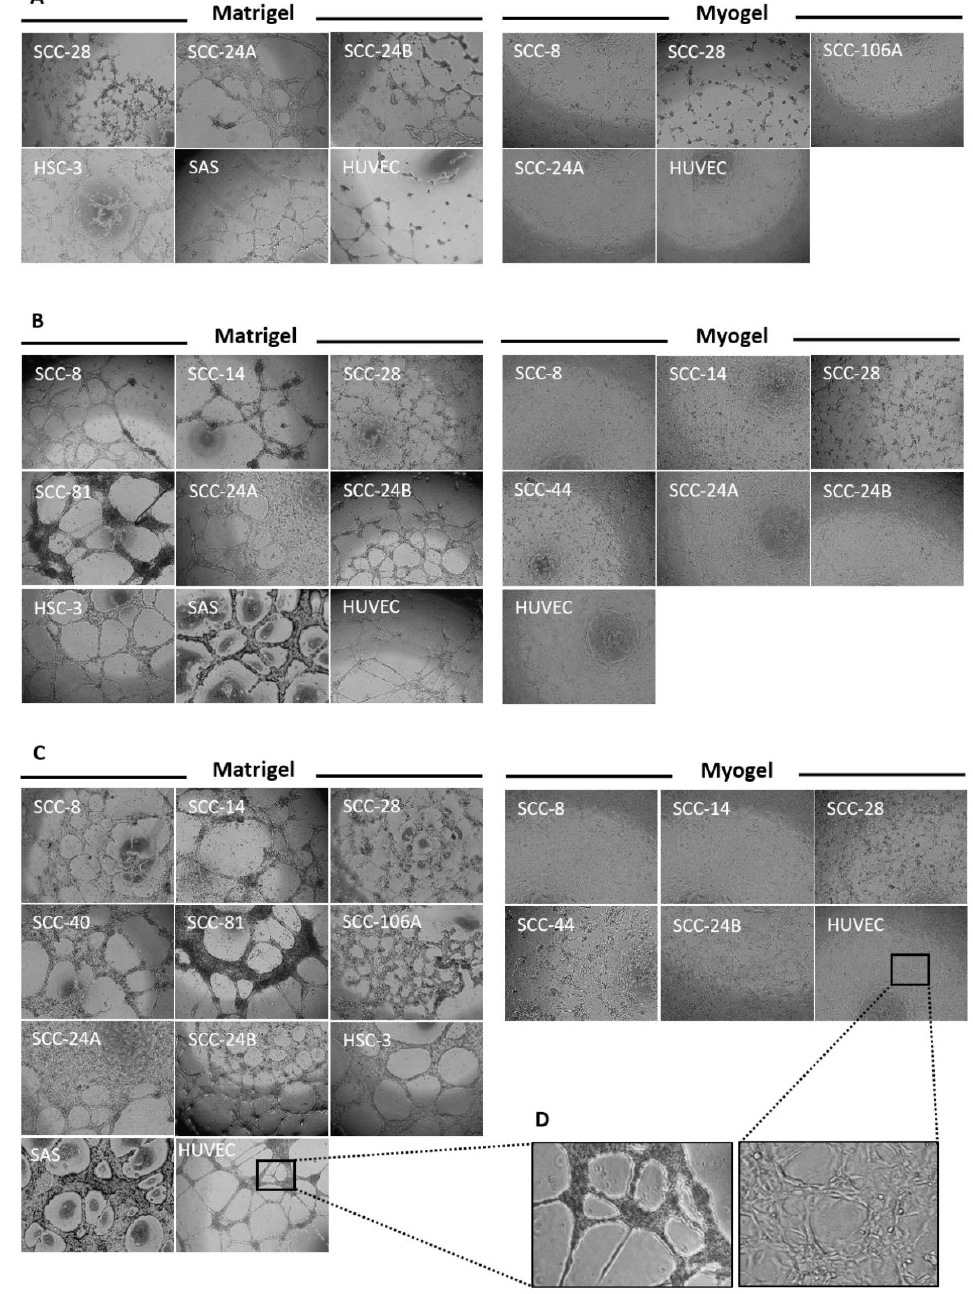
Figure 2. Assessment of tumour cell-derived tubulogenesis in vitro. ( A ) Thirteen cell lines derived from head and neck squamous cell carcinoma (HNSCC) and normal human endothelial cells (HUVEC) were seeded at a starting cell density of 20 × 10 3 cells on Matrigel or Myogel. All of the highly metastatic HNSCC cell lines (namely, SCC-24B, HSC-3, and SAS) formed a VM meshwork in Matrigel only, while more primary cell lines formed such tubes in Myogel ( n = 4). HUVEC formed tubes in both matrices. ( B ) At a higher starting cell density of 40 × 10 3 , all metastatic and some primary HNSCC cell lines ( n = 7) developed longer and more interlaced VM meshwork in Matrigel. In Myogel, primary tumour cell lines ( n = 5) continued to form VM structures with the most extensive meshwork attained by cells originating from the floor of the mouth and gingiva (SCC-28 and SCC-44, respectively). Additionally, the metastatic cell line (SCC-24B) started to initiate consistent tubes in Myogel that were more extensive than its primary counterpart (SCC-24A). ( C ) When the starting cell density reached 60 × 10 3 , only metastatic and merely two primary cell lines continued to develop thicker and longer VM networks in Matrigel compared with four primary cell lines in Myogel. ( D ) The HUVEC meshwork has become shorter and more interlaced in Myogel. The images were taken at a magnification of 4 ×